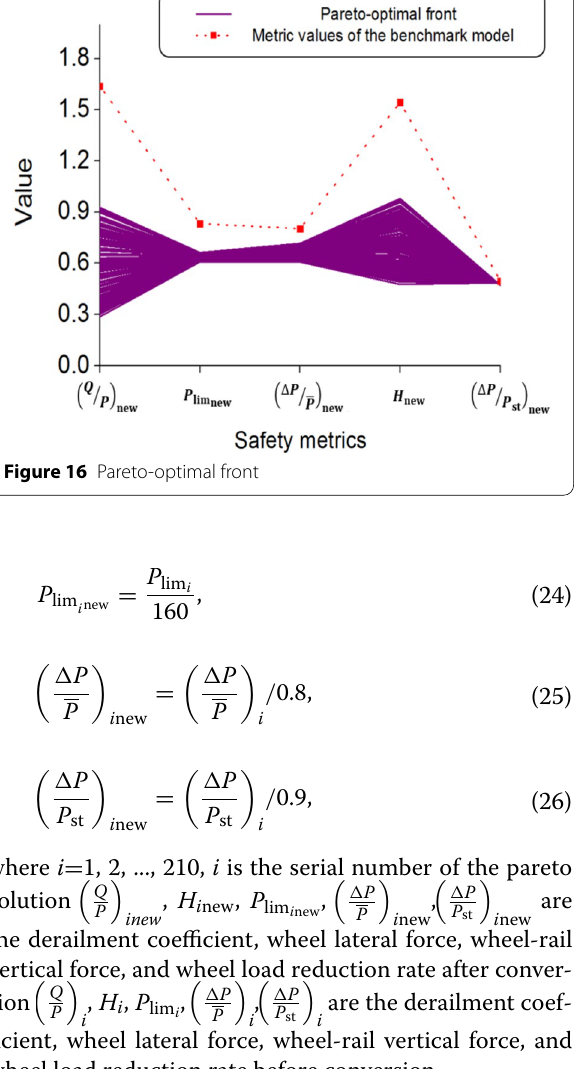
ficient, wheel lateral force, wheel-rail vertical force, and wheel load reduction rate before conversion.